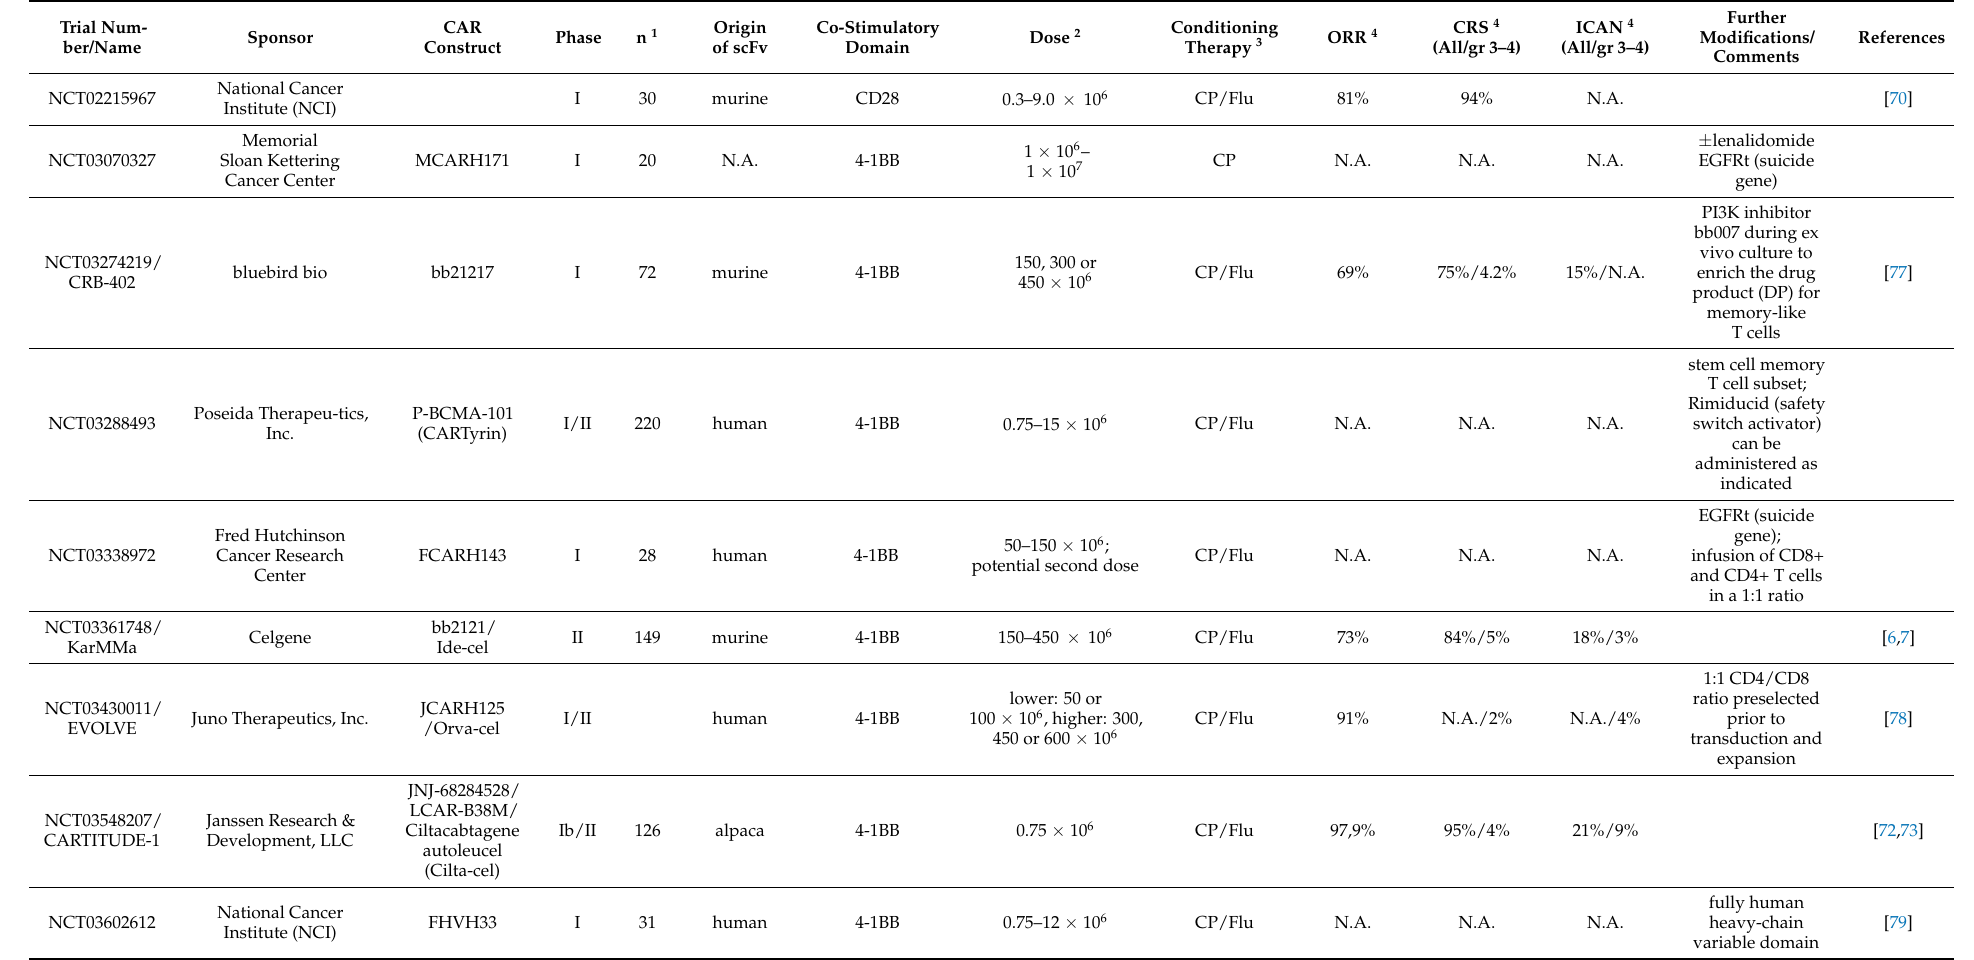
Table 2. Selection of important clinical trials for BCMA-CAR transgenic T cells (information from